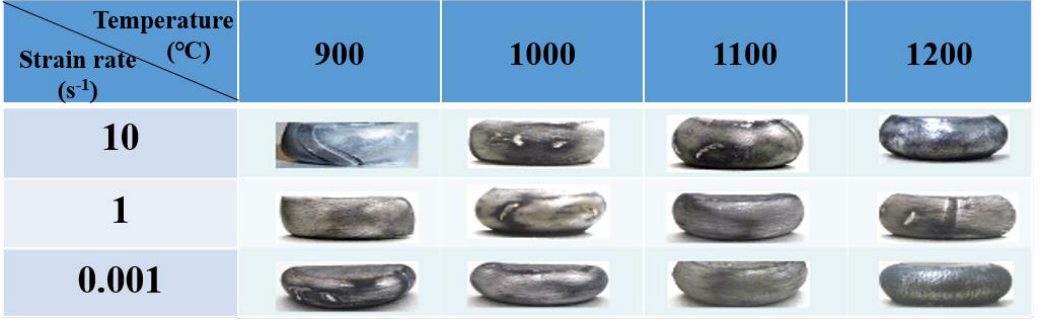
Figure 2. Side views of the UF-TiB/Ti-6Al-4V composite deformed at various temperatures and strain